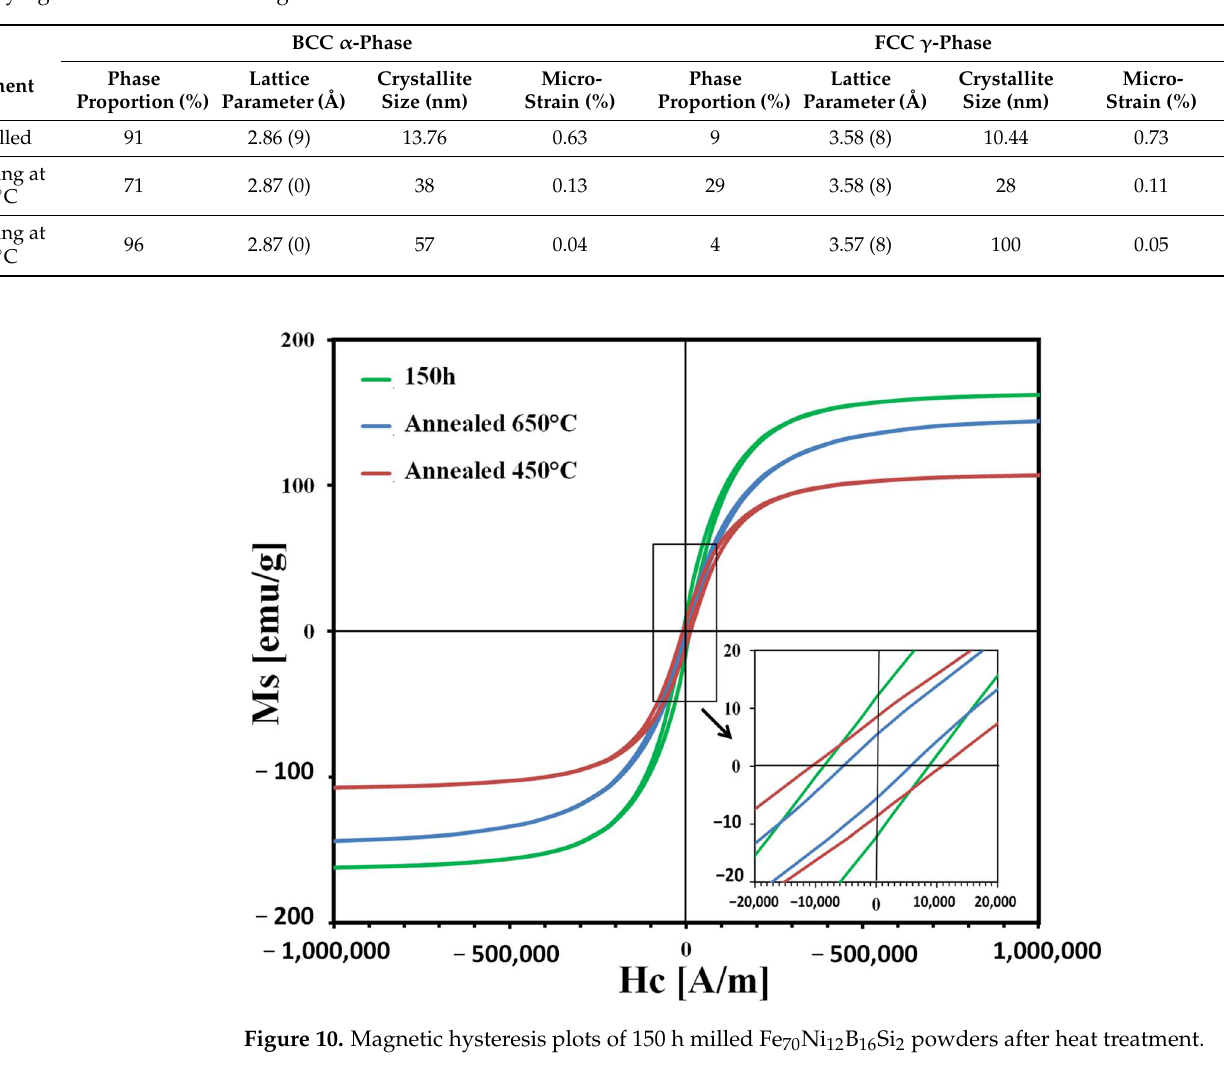
Table 3. Evolution of structural and microstructural proprieties in the investigated Fe 70 Ni 12 B 16 Si 2 alloy after mechanical alloying for 150 h and annealing.